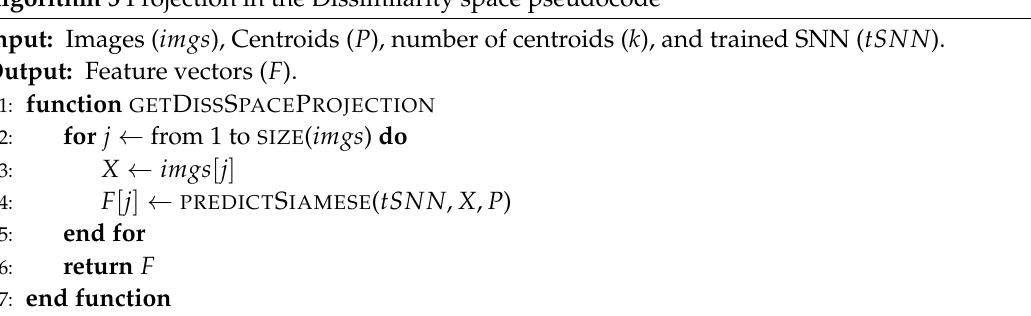
Algorithm 5 Projection in the Dissimilarity space